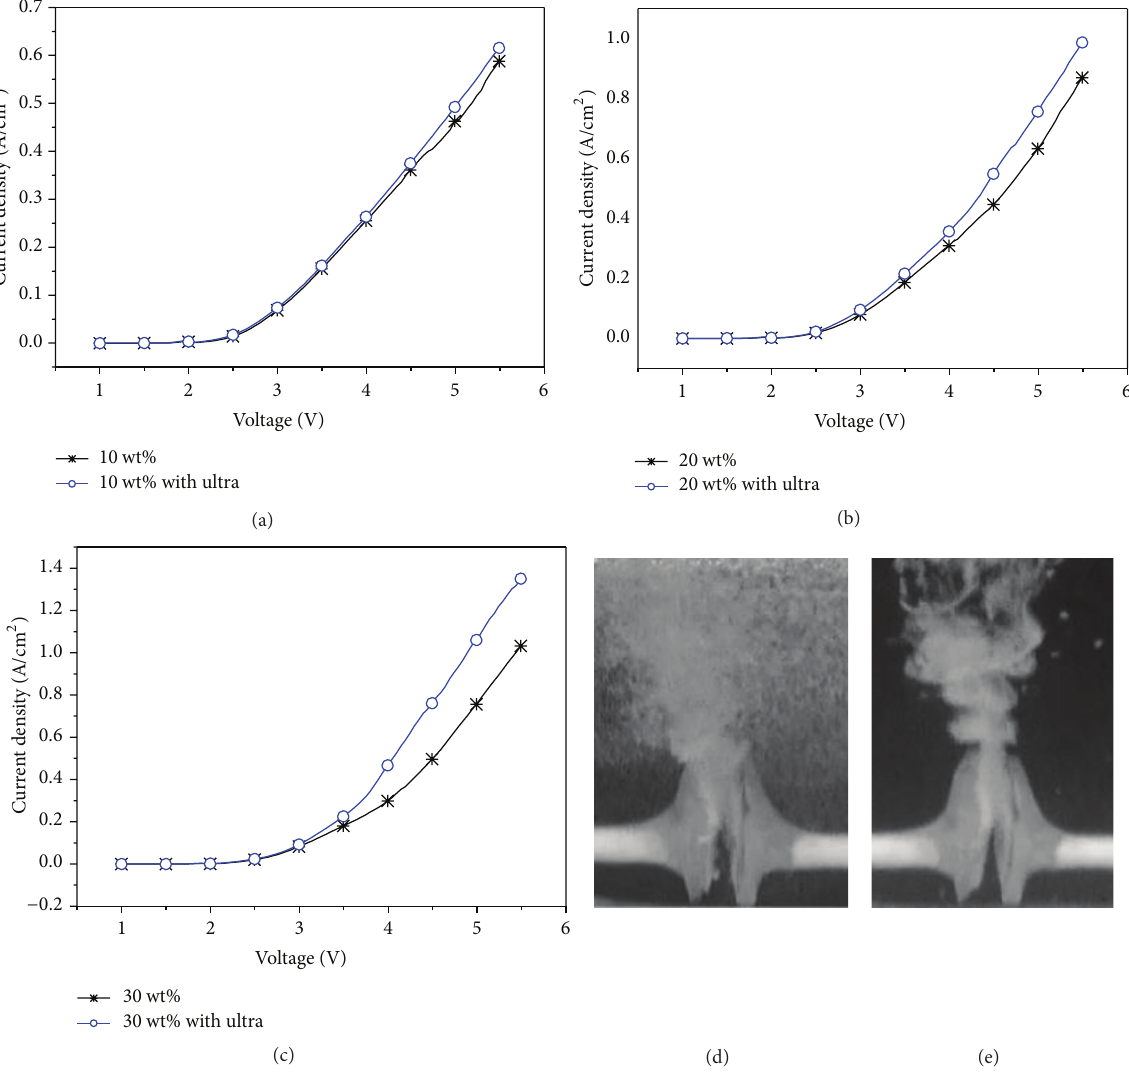
Figure 4: The effect of applying ultrasound on the water electrolysis for Al-Mg (25 wt%) electrode. (a) 10 wt%, (b) 20wt%, (c) 30 wt% KOH electrolyte, (d) bubbles (without ultra), and (e) bubbles (with